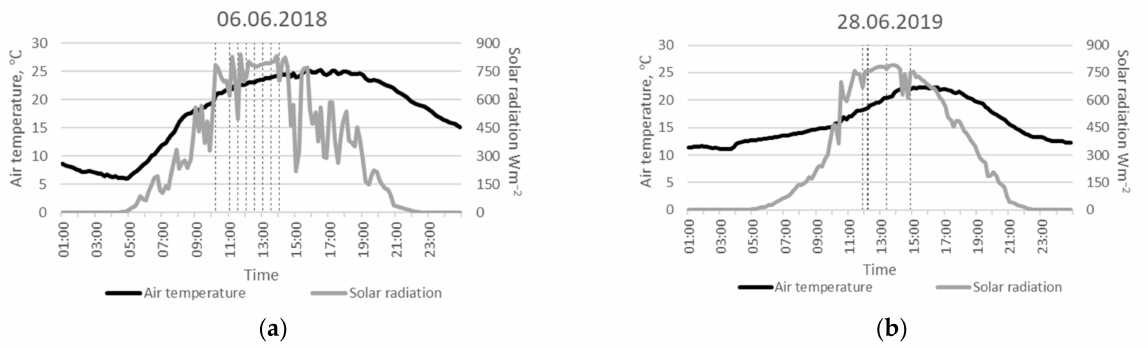
Figure A3. Mean hourly temperature, solar incoming radiation and flight times for the diurnal field experiments with winter wheat in 2018 ( a ) and 2019 ( b ) in Denmark. Vertical lines indicate the time of the UAS